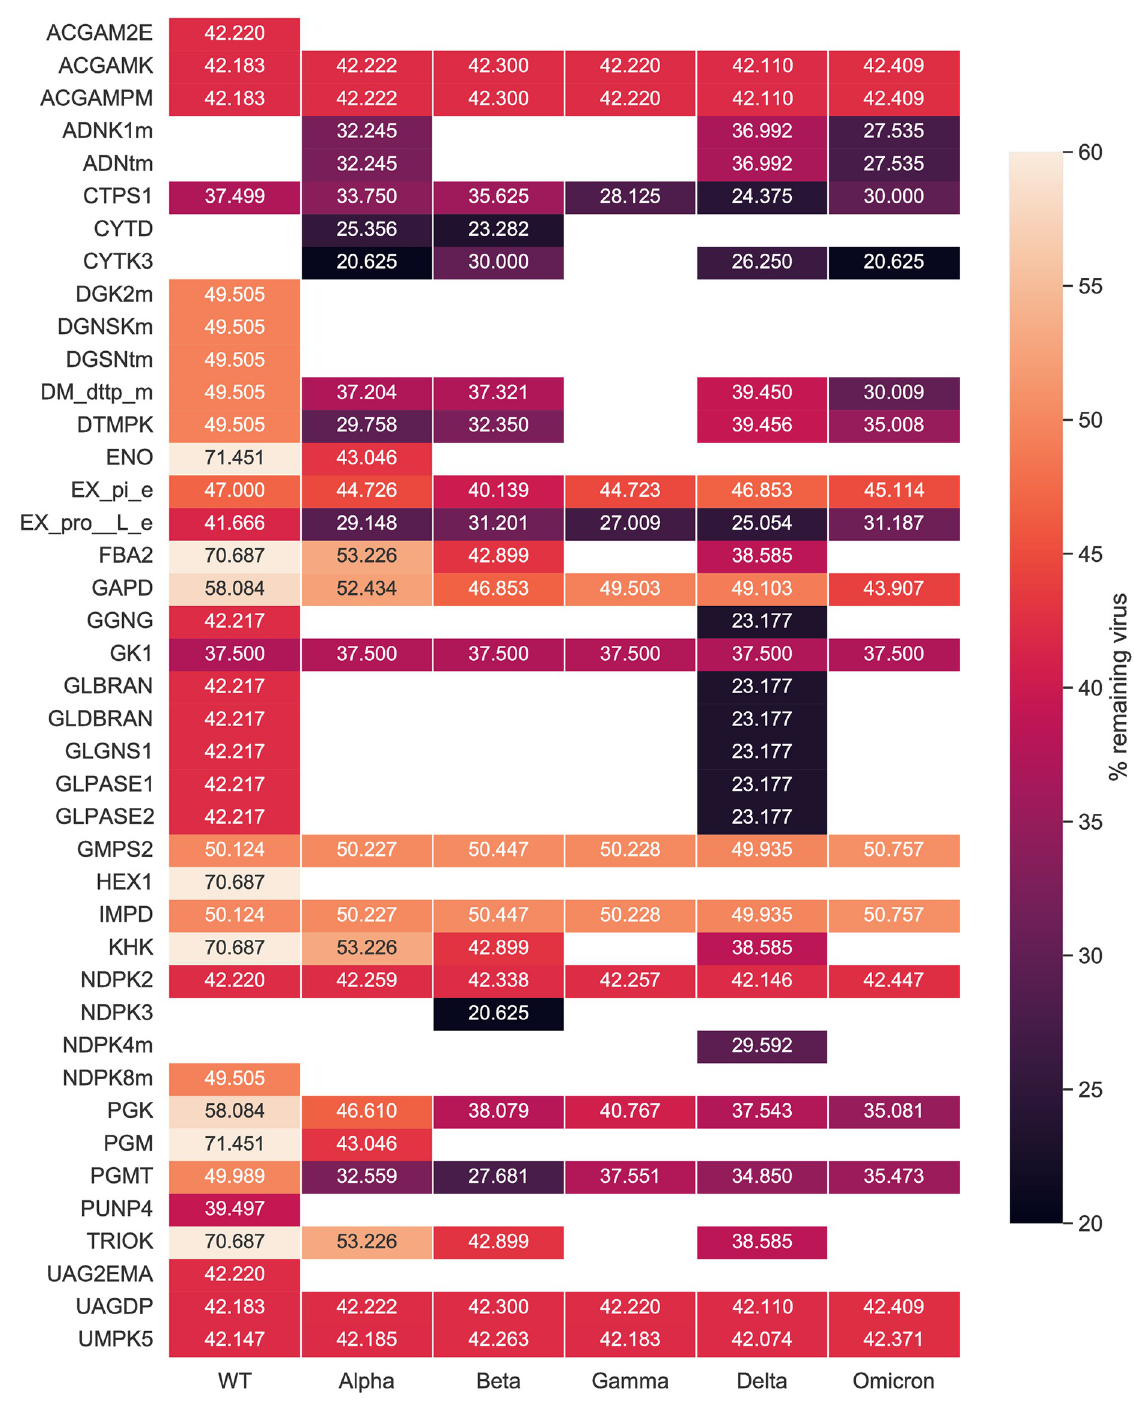
Fig 9. Results of the host-derived enforcement applied to all known variants of concern. The range and effect of reaction inhibitions on the VBOF were calculated while keeping the host’s maintenance at 100%. Only targets predicted across all retrieved sequences for a single variant were considered robust and were examined further. Empty cells in the heatmap represent targets that were not predicted as potential inhibitors for the corresponding variant. CTPS1 showed the highest inhibitory effect against the virus at all studied variants, followed by GK1 . Targeting the amino sugar and nucleotide carbohydrate metabolism highlighted to be a robust hit against all studied variants.